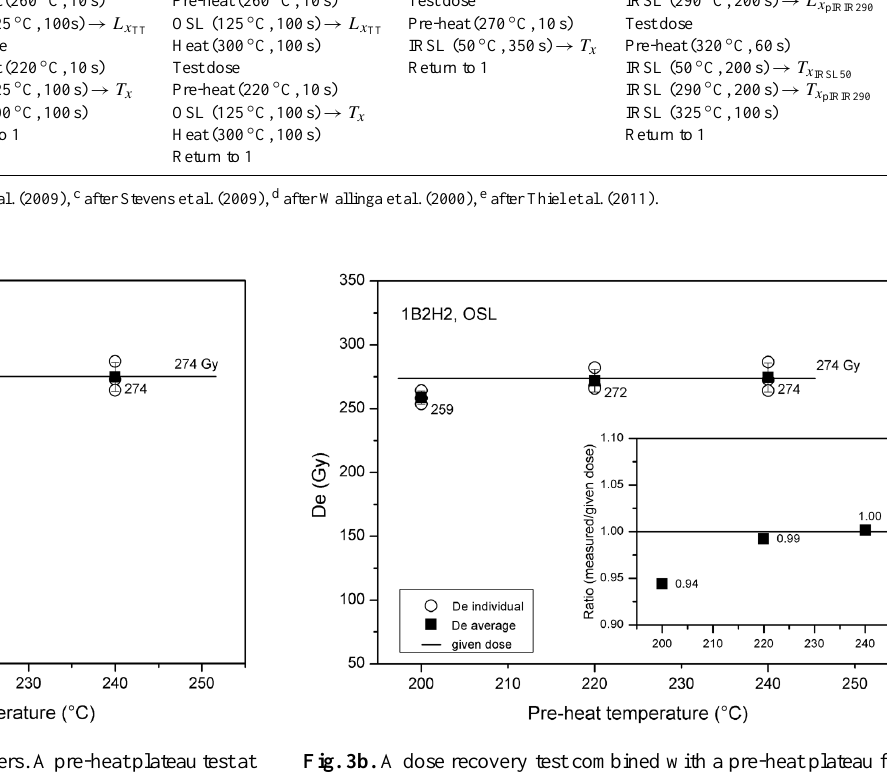
Fig. 3b. A dose recovery test combined with a pre-heat plateau for fine grain quartz. Samples were first bleached by a 100s shine down at 125 ◦ C to reset the natural luminescence signal and then irradi- ated with a 274Gy beta dose. Three sub-samples each were mea- sured at three different temperatures and yielded a perfect match at 240 ◦ C with the given dose (ratio is 1.00, see inset), if the exponen- tial plus linear function is fitted for D e